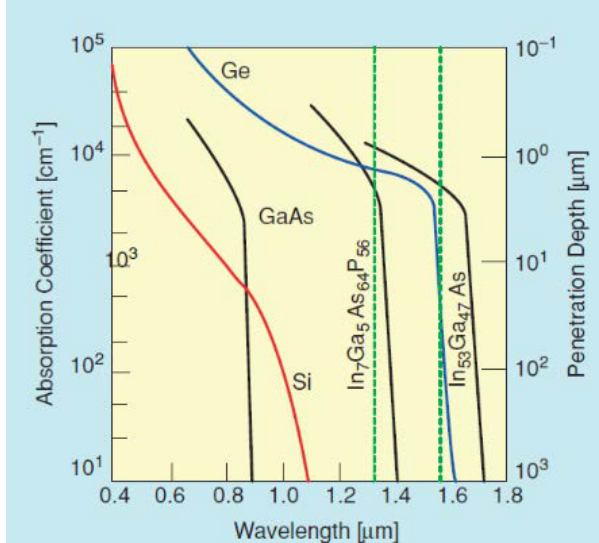
Figure 1: Absorption coeflcient and penetration depth of various bulk materials as a function of wavelength. The green dashes mark typical wavelengths for the telecom window of 1310 and 1550